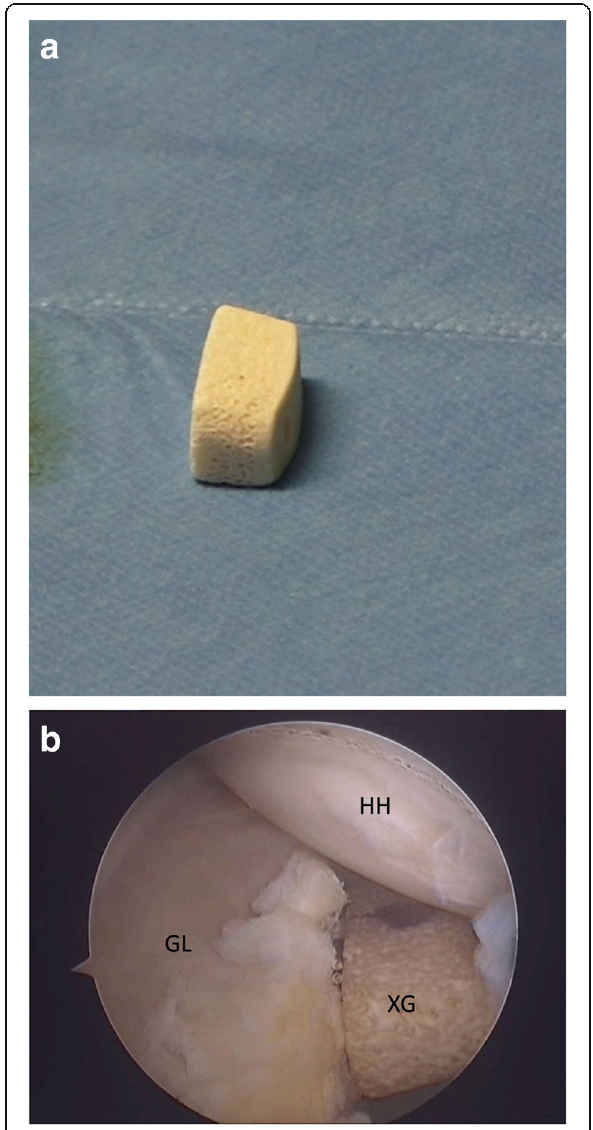
Fig. 4 Left shoulder, anterior on the right and posterior on the left, scope from antero-superior portal. The preformed Xenograft ( a ) positioned on the glenoid anterior neck ( b ). (HH: humeral head, GL: glenoid, XG: Xenograft)